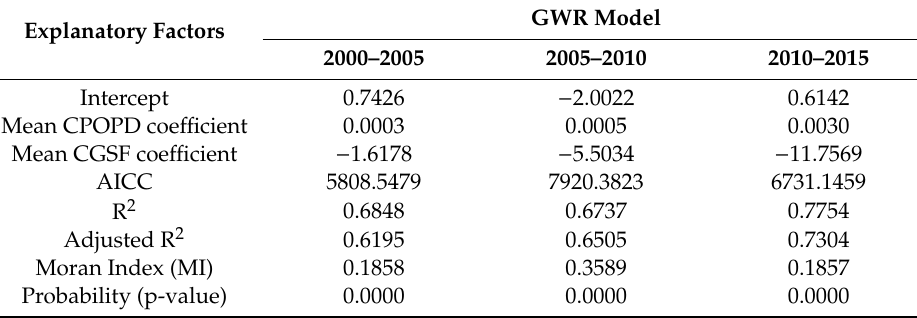
Figure 8. Local R 2 of the GWR model: ( a ) 2000–2005; ( b ) 2005–2010; ( c ) 2010–2015. Table 4. Results and diagnostics of GWR analysis in di ff erent